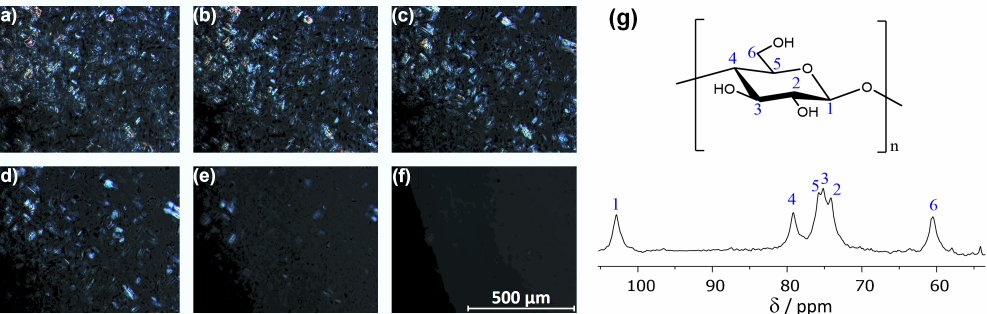
Figure 5. ( a – f ) Polarized optical microscopy (POM) images showing the dissolution of microcrystalline cellulose in [EMTr][OBz] at T = 60 ◦ C (4 wt.-% cellulose in 200mg [EMTr][OBz]). The pictures were